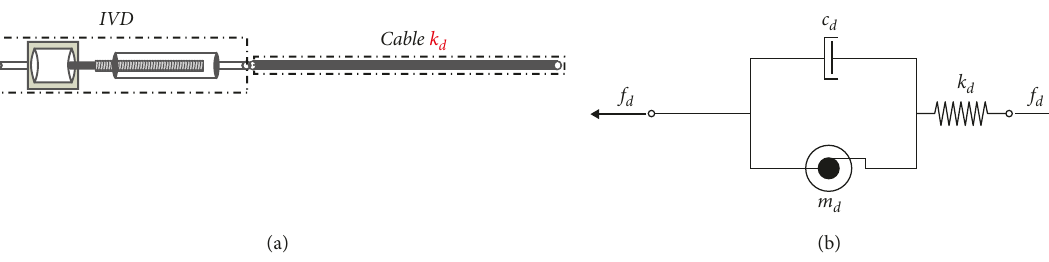
Figure 3: Mechanical model of a cable inerter viscous damper (CIVD): (a) CIVD; (b) mechanical